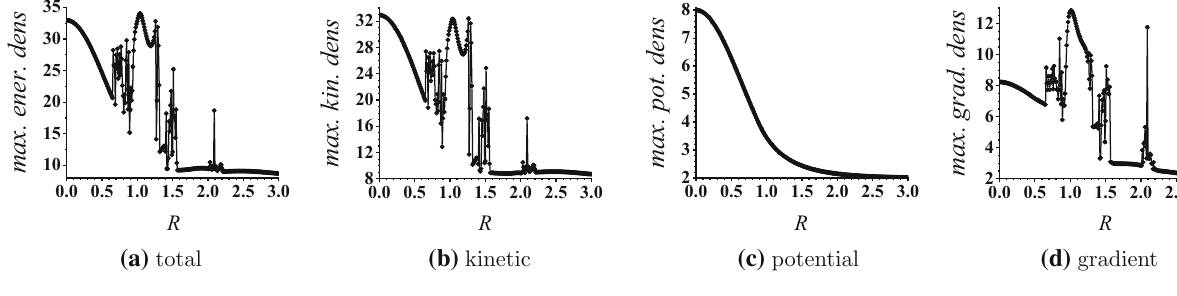
Fig. 6 Maximal energy densities as functions of R for kink–antikink collisions at v